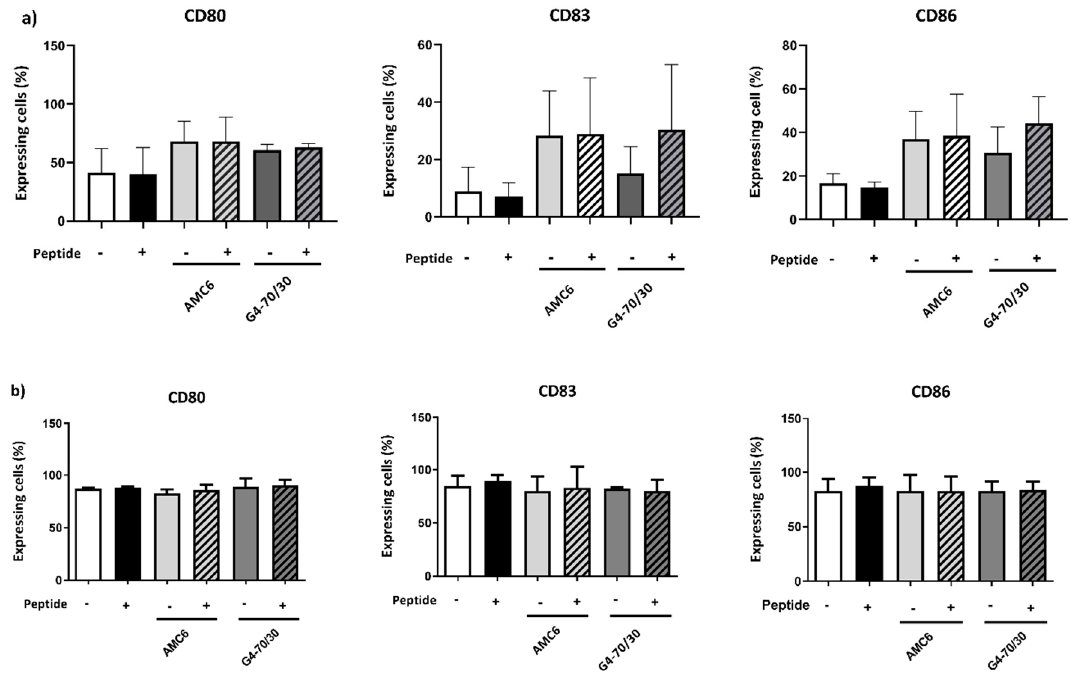
Figure 5. Incubation with the peptide, nanocompounds or complexes does not affect DC maturation. ( a ) iDCs were treated with AMC6 nanoparticle or G4-70/30 dendrimer with and without peptide. ( b ) DCs maturation were induced by treatment with CD40L and TNF- α upon treatment with AMC6 or G4-70/30 with and without peptide. After 48 h, cells were stained with fluorescent antibodies against CD14, CD1a (to detect differentiated DCs) CD80, CD83 and CD86. DC marker expression was measured by flow cytometry. No significant difference was found between untreated and treated cells. Symbol + indicates the presence of the compound and – its absence.